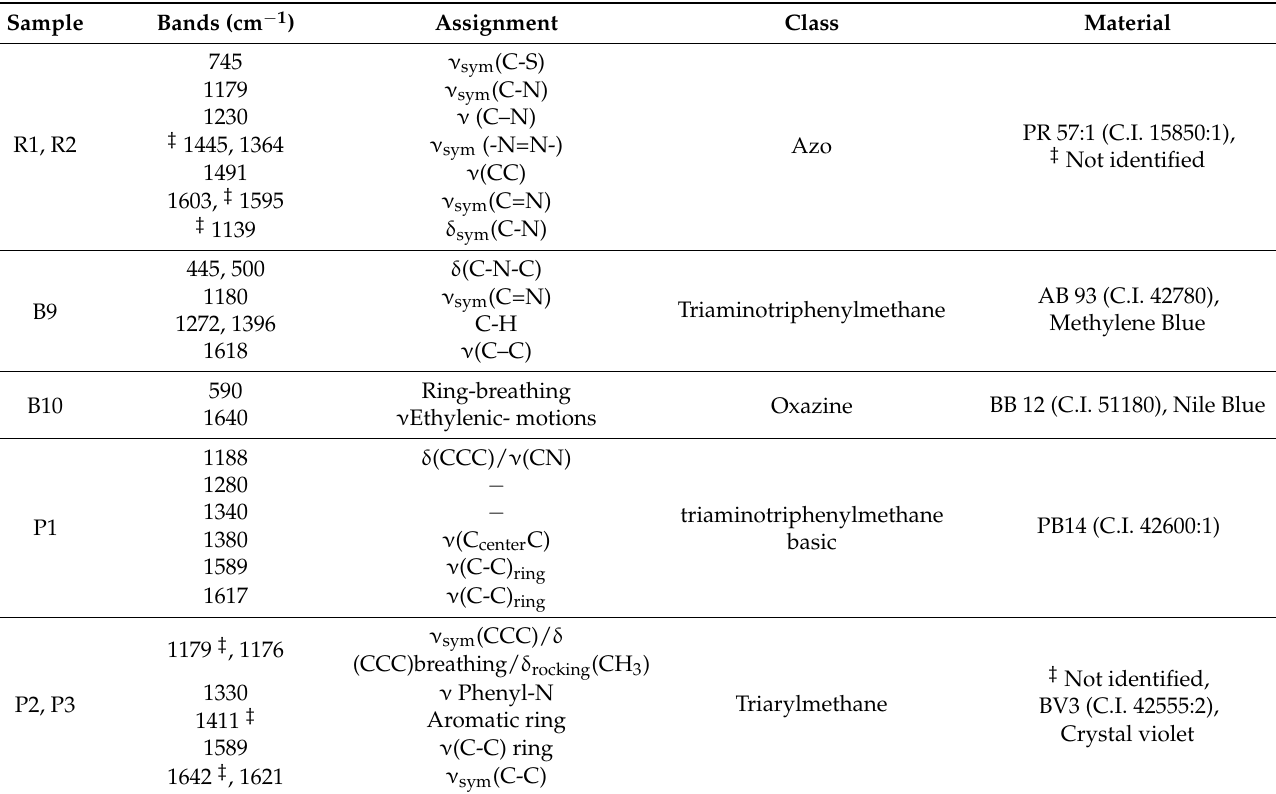
Table A2. Summary of the main Raman bands and their tentative assignment of synthetic